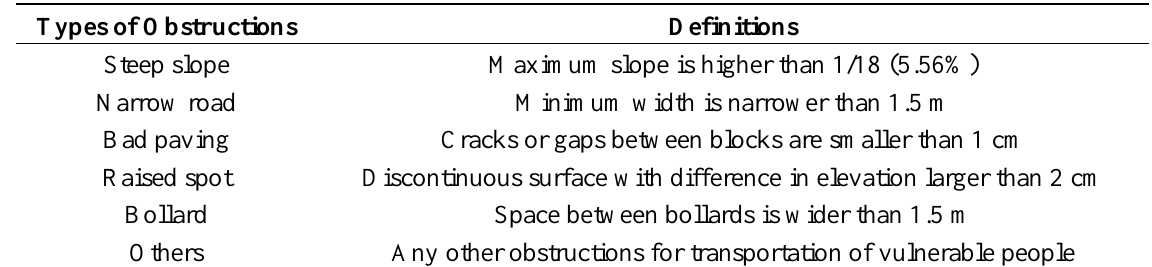
Table 2. Definitions for Obstructions.